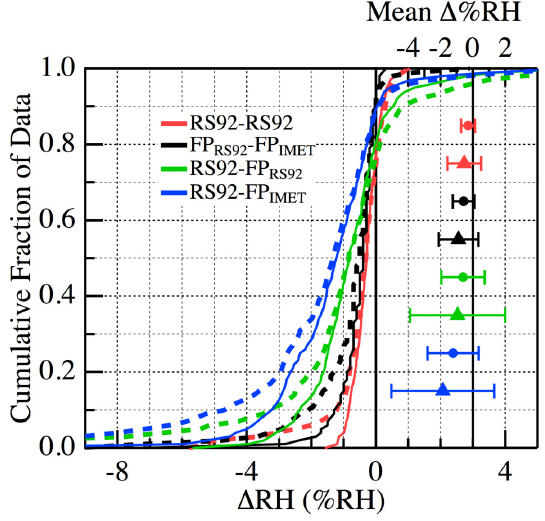
Fig. 12. CDFs and Gaussian statistics of 1 RH for RS92-RS92, FP RS92 -FP IMET , RS92-FP RS92 and RS92-FP IMET . The latter two sets of RH reflect differences between direct RH measurements by RS92 sondes and RH values calculated from frost point hygrom- eter measurements using T data from the RS92 and iMet sondes, respectively. 1 RH above 20km were excluded from each compari- son. Though the CDF for every 1 RH data set is shifted negatively, only the inner-68% ranges of FP RS92 -FP IMET and RS92-FP IMET expose median 1 RH values that are statistically different from zero. All of the standard deviation ranges include